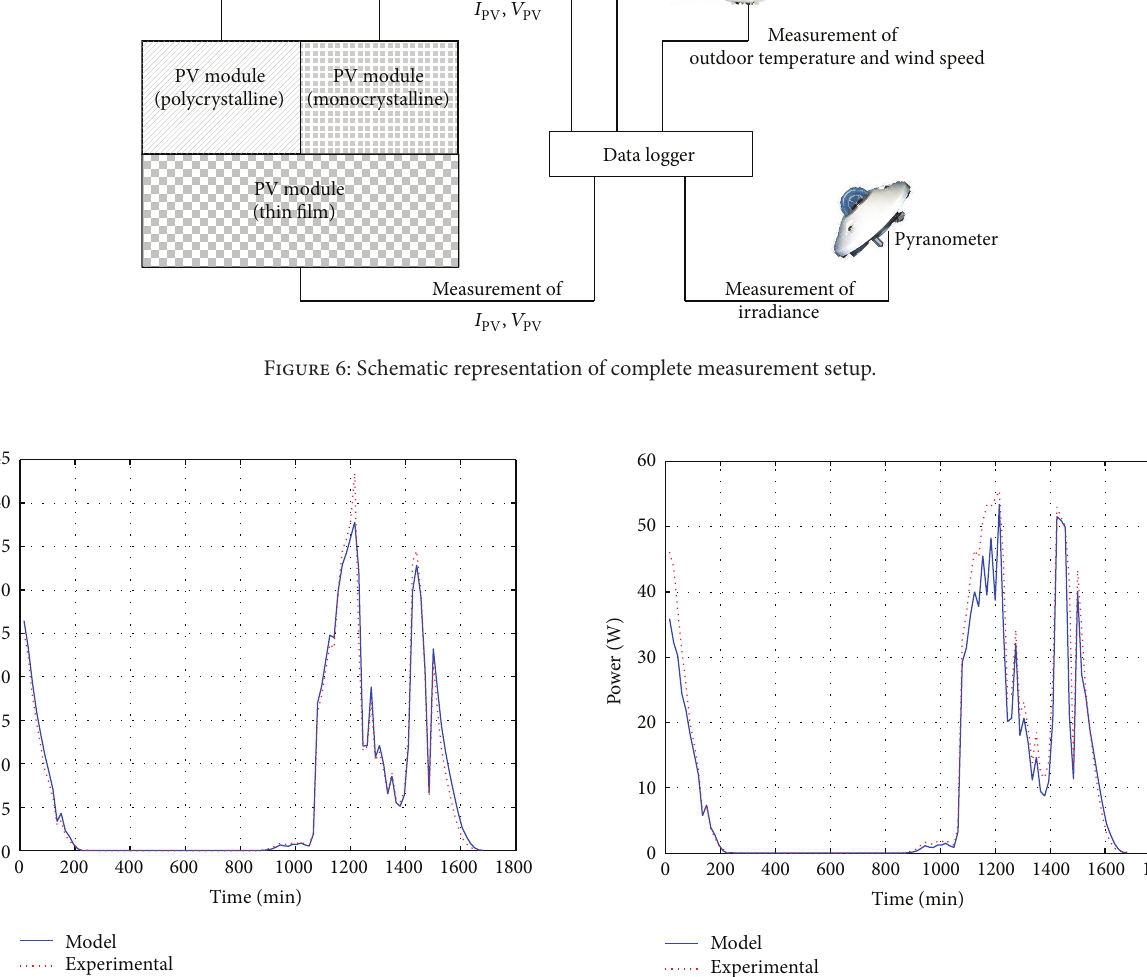
Figure 8: Comparison of the simulation results and polycrystalline silicon panel